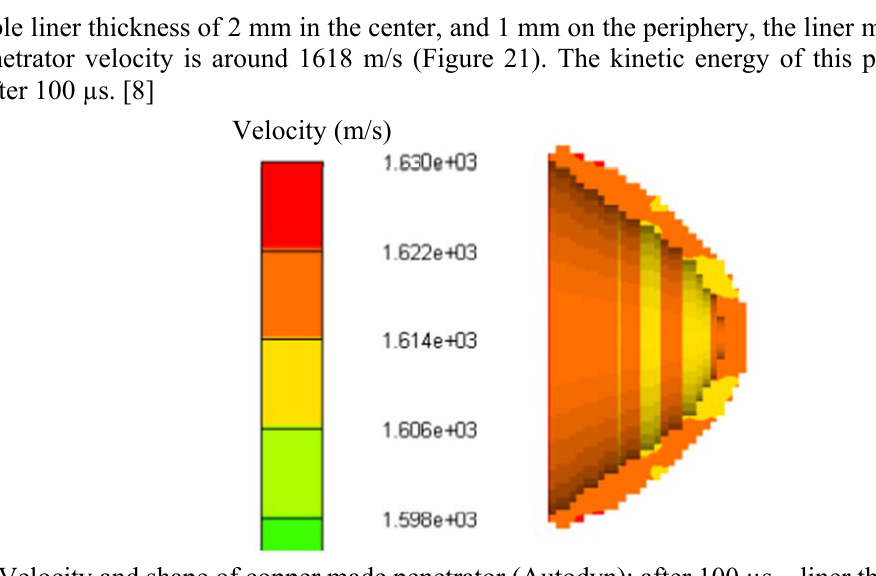
Figure 21. Velocity and shape of copper made penetrator (Autodyn); after 100 µs – liner thickness is variable (2 mm – center; 1 mm – periphery)